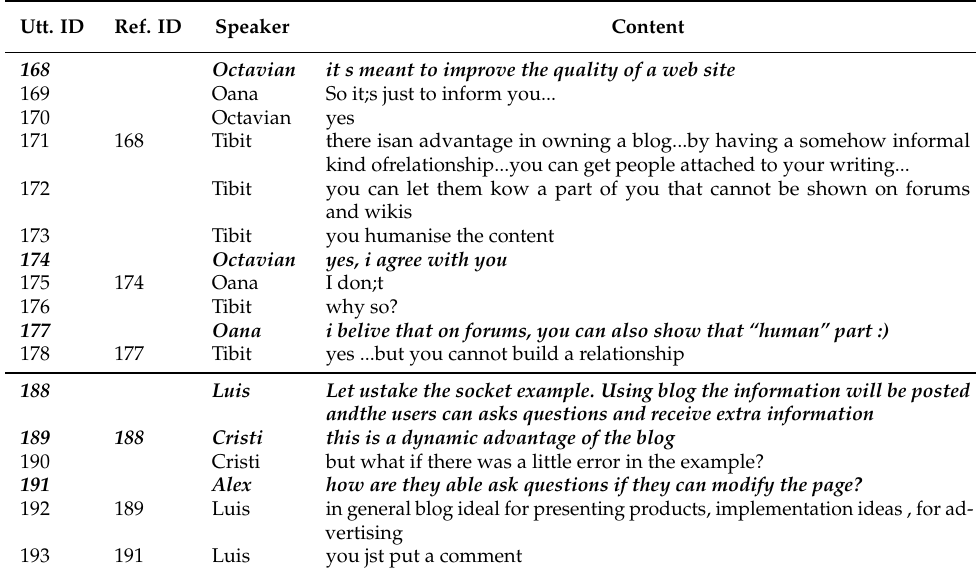
Table 9. Example of correct semantic link prediction ( explicit link / predicted link